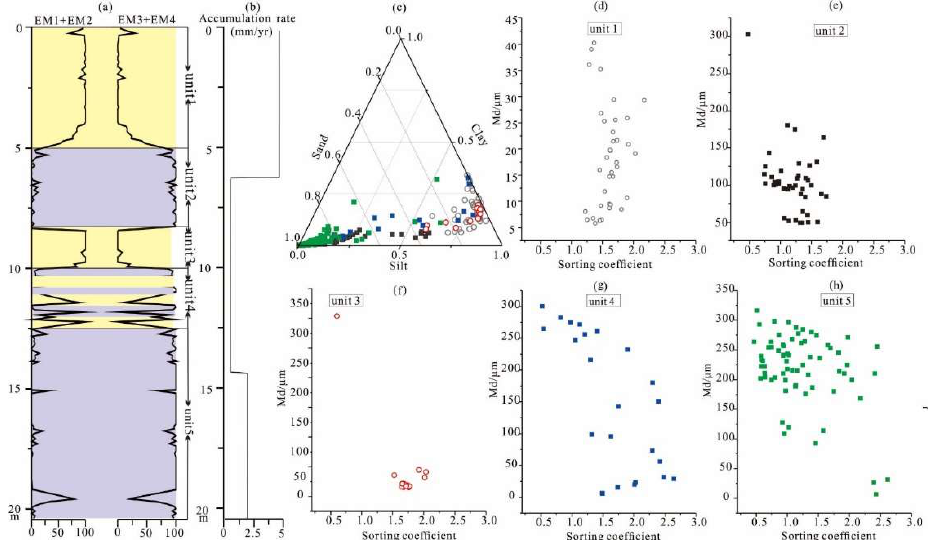
Figure 6. Sedimentary sequence of fluvial deposits at HDZ04. ( a ) Energy values are calculated by the total value of EM3 and EM4 or EM1 and EM2. ( b ) Accumulation rate of fluvial deposits. ( c ) grain-size composition of sediments from different units in HDZ04. Relationships between median diameter and sorting coefficient in sediments from unit 1 ( d ), unit 2 ( e ), unit 3 ( f ), unit 4 ( g ) and unit 5 ( h ).